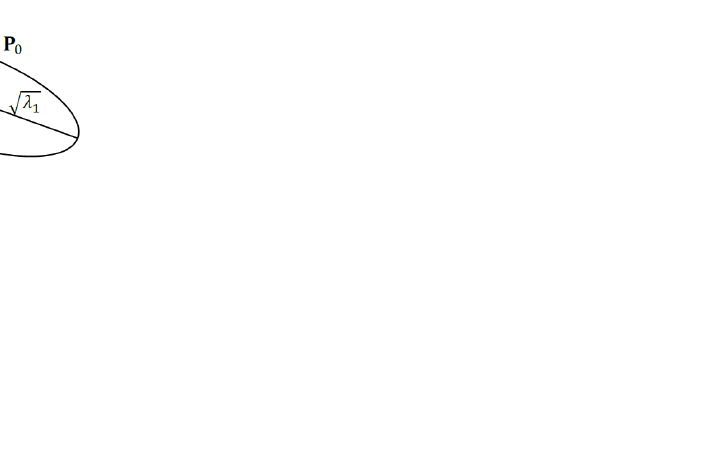
Figure 3. Optimal sensor placement in 2D using the D-optimality criterion with Gaussian prior N ( x ) 0 , P 0